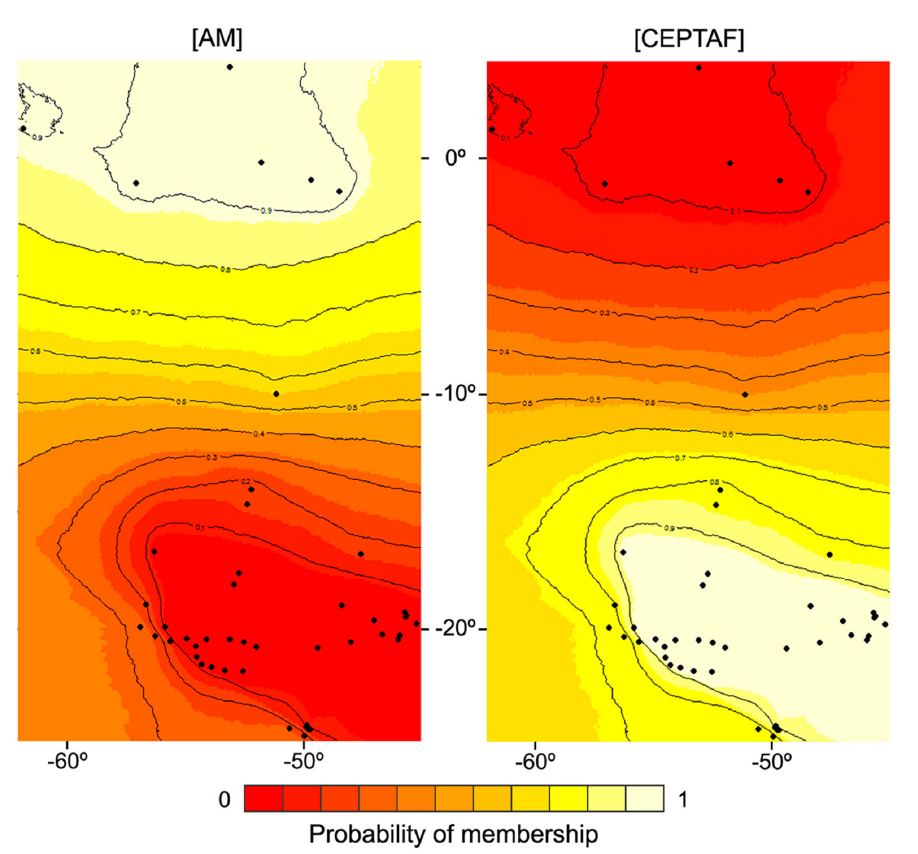
Figure 3. Map of posterior probabilities of membership for the two most likely clusters detected by Geneland using concatenated mtDNA data. AM: Amazon cluster; CEPTAF: Cerrado, Pantanal, and Atlantic Forest cluster.